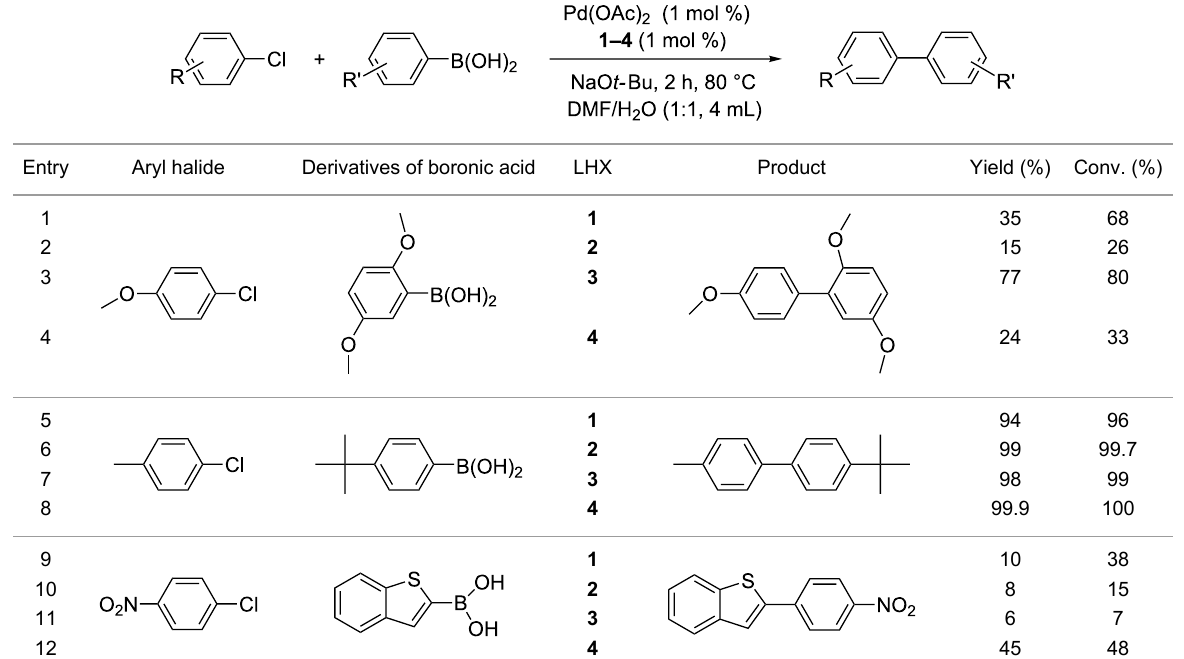
a Reaction conditions: 4-methoxy-1-chlorobenzene, 4-chlorotoluene, 4-chloronitrobenzene (1.0 mmol), Pd(OAc) 2 (1.0 mol %), 2,5-dimethoxyphenyl- boronic acid, 4- tert -butylphenylboronic acid, thianaphthene-2-boronic acid (1.5 mmol), NaO t -Bu (2.0 mmol), 1–4 (1 mol %), DMF/H 2 O (1:1, 4 mL),